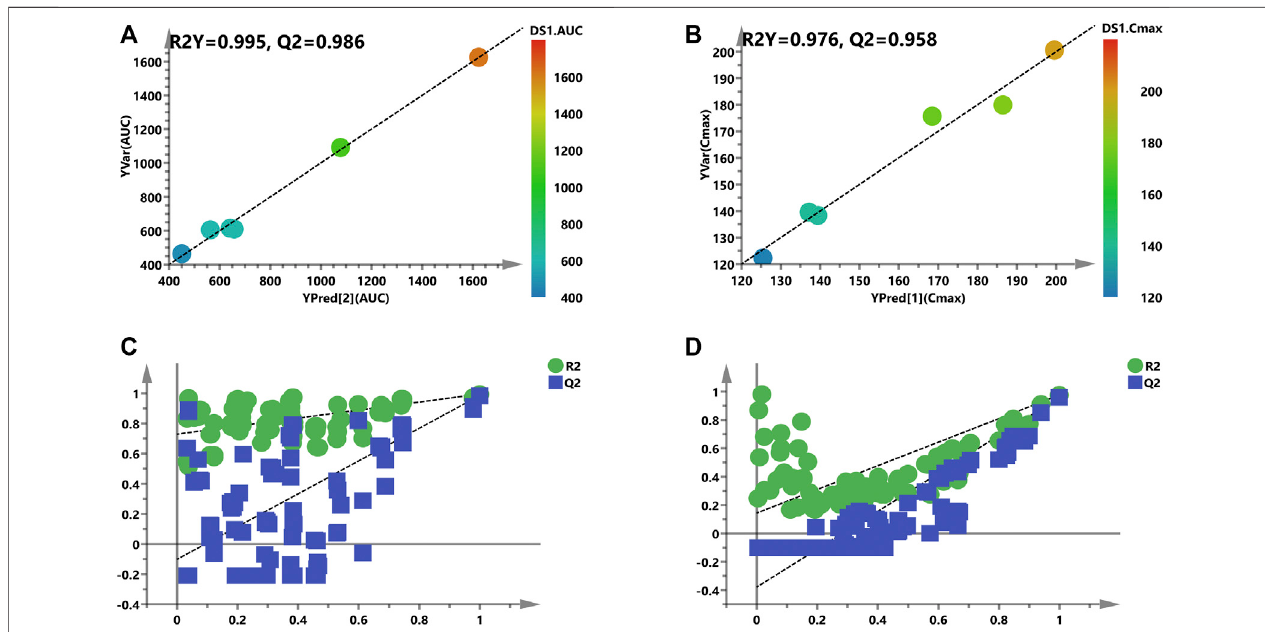
FIGURE 7 | Re fi ned models to predict individualized PK parameters based on the screened biomarkers. (A) and (B) are regression plots of the predicted PK parameters vs. the measured PK parameters (AUC or C max ). The color from blue to red indicates the corresponding PK values from low to high. (C) and (D) are the resulting plots of the permutation test to identify the re fi ned prediction models (A) and (B) without the risk of over fi tting.